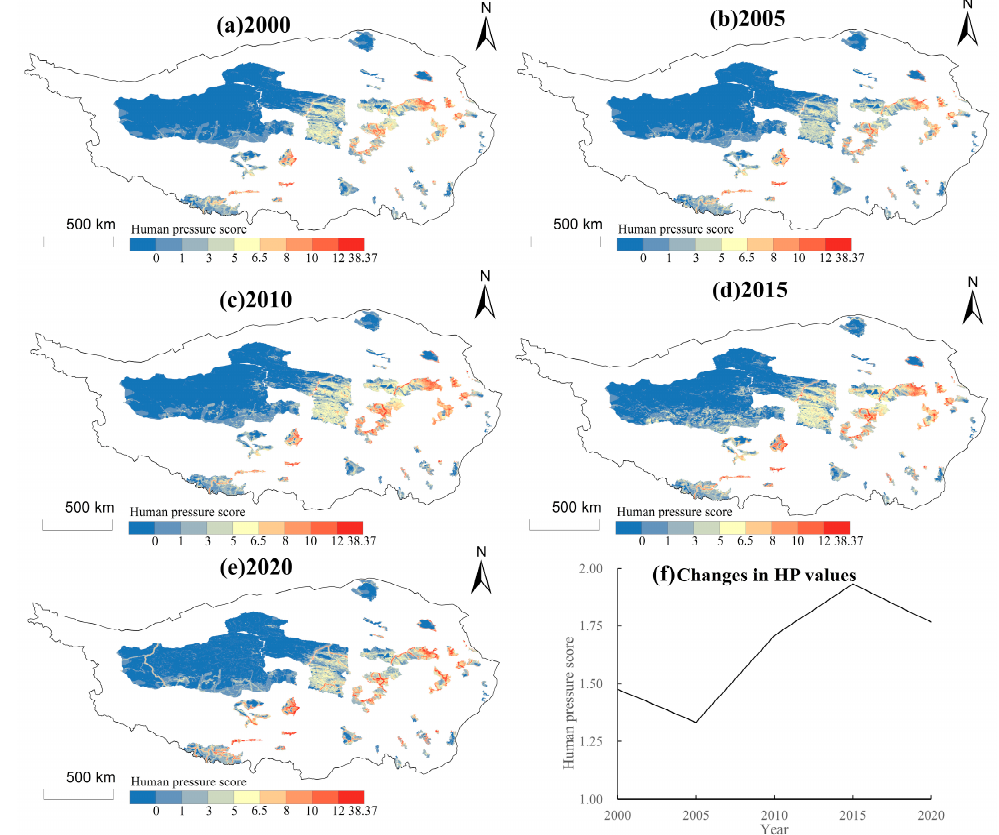
Figure 2. Spatiotemporal changes in HP in the NRs of the Qinghai–Tibet Plateau for 2000–2020. Table 3. Disturbance values of fi ve HPs in the NRs of the Qinghai–Tibet Plateau for 2000–2020.